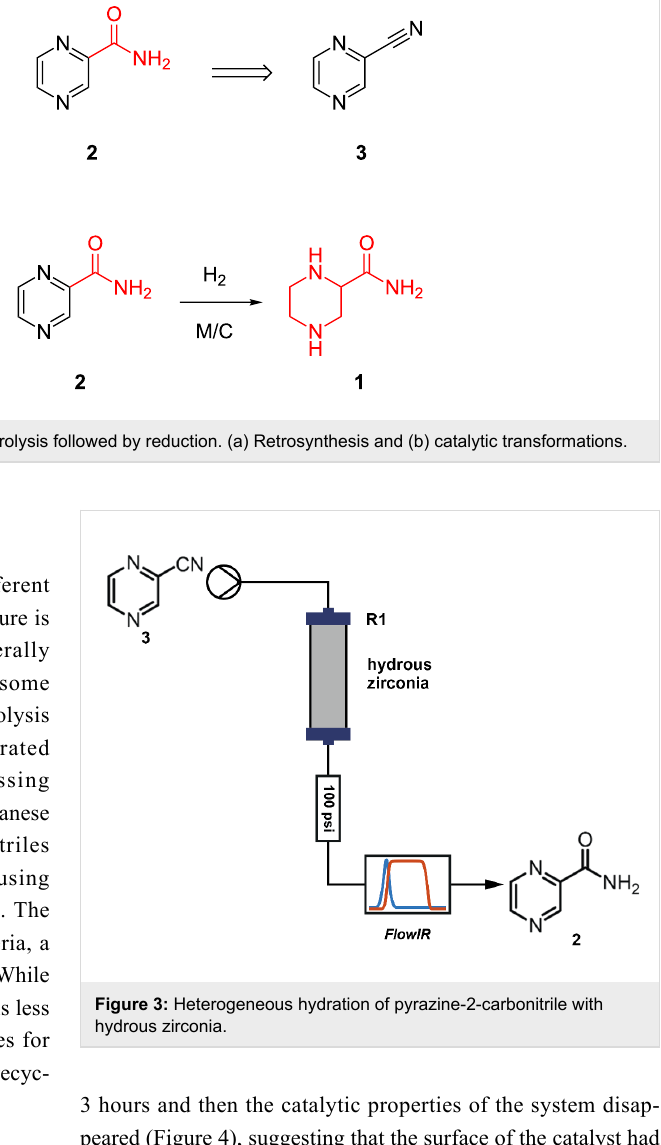
3 hours and then the catalytic properties of the system